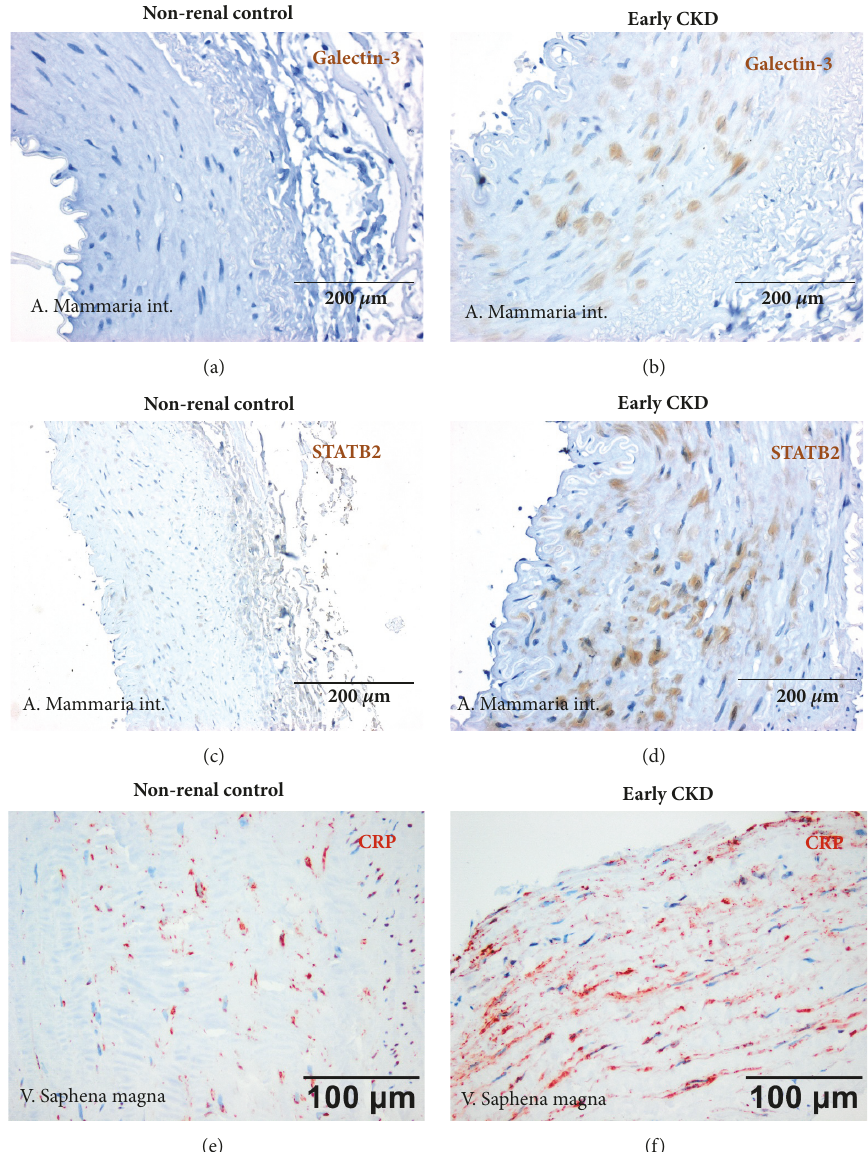
Figure 2: (a-f) Rep r esentative vascula r changes in non r enal cont r ol patients (a, c, e) and patients with ea r ly ch r onic kidney disease (CK D ). (a, b) Increased expression of galectin-3 in arteria mammaria int. in early CKD patients (b) compared to nonrenal controls (a). Immunohistochemistry.(c,d)MarkedincreaseinSTAB2expressioninarteriamammariaint.inearlyCKDpatients(d)comparedtononrenal controls (d). Immunohistochemistry. (e, f) Increased staining for C-reactive protein (CRP) in vena saphena magna in early CKD patients (f) compared to nonrenal controls (e).